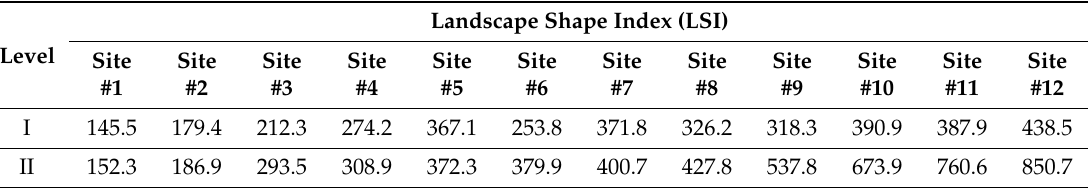
Table 4. Landscape shape index (LSI) value of twelve study sites.